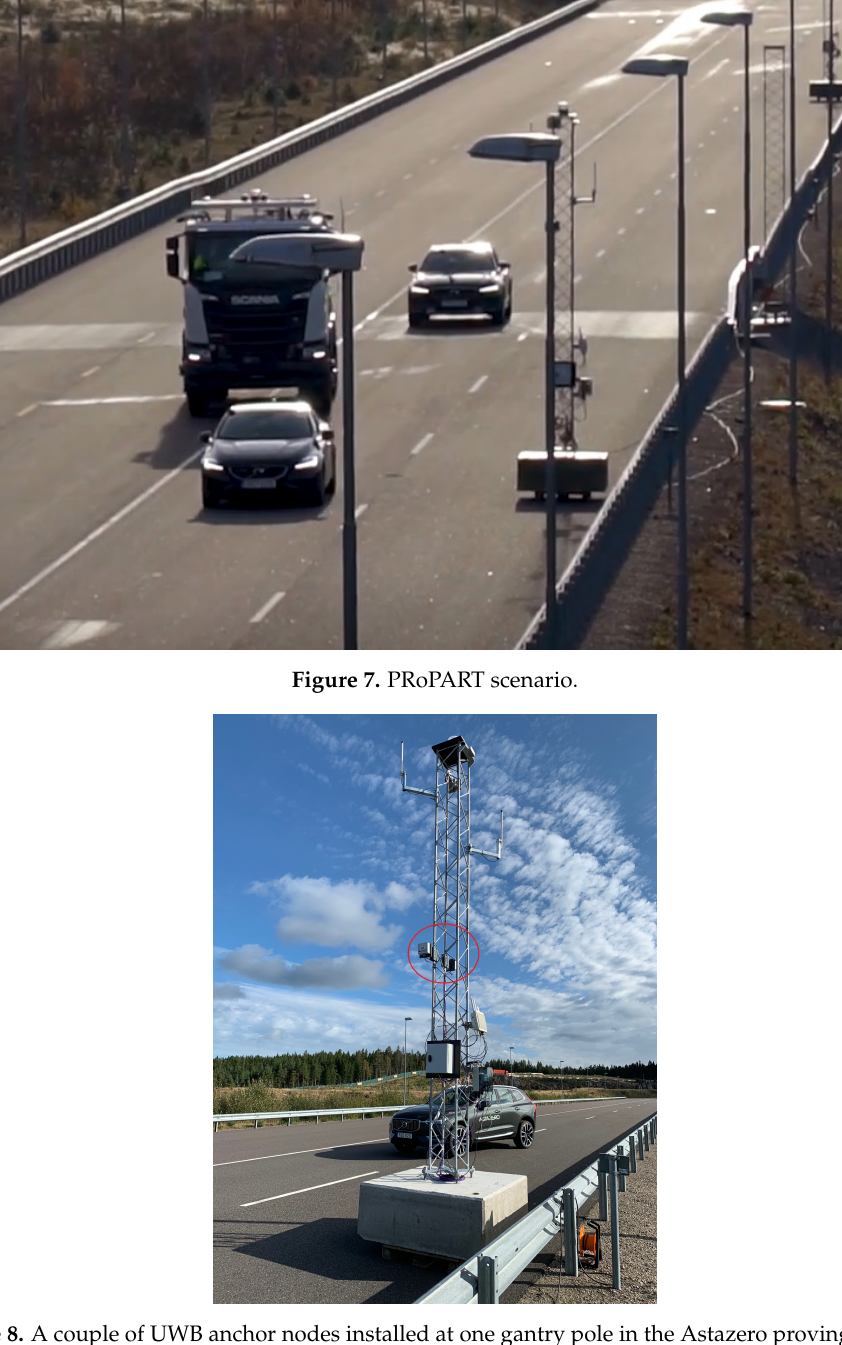
Figure 8. A couple of UWB anchor nodes installed at one gantry pole in the Astazero proving